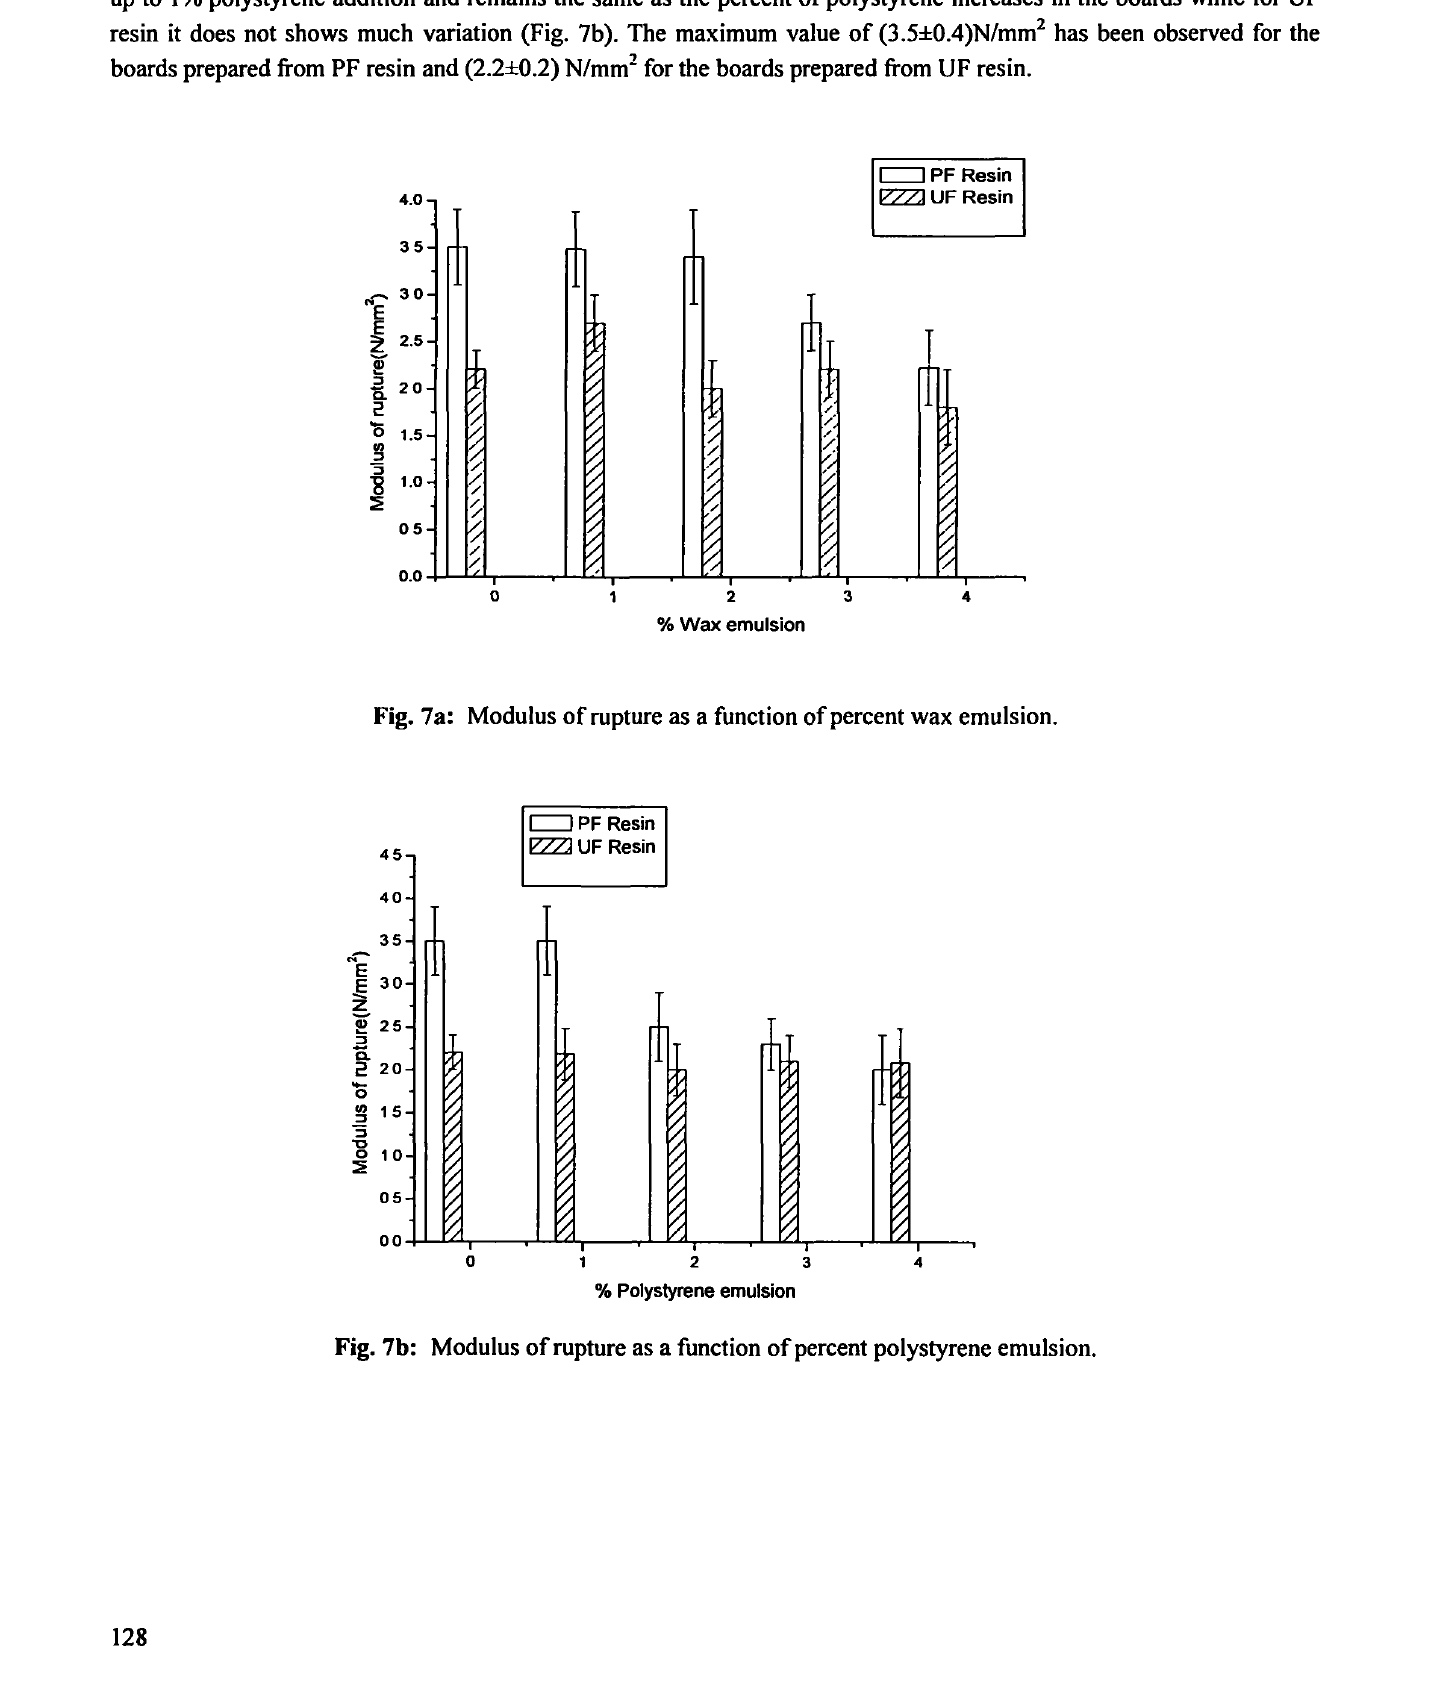
Fig. 7a: Modulus of rupture as a function of percent wax emulsion.